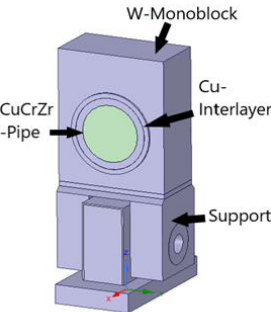
Figure 3. Geometrical description of the ITER-Like PFC concept